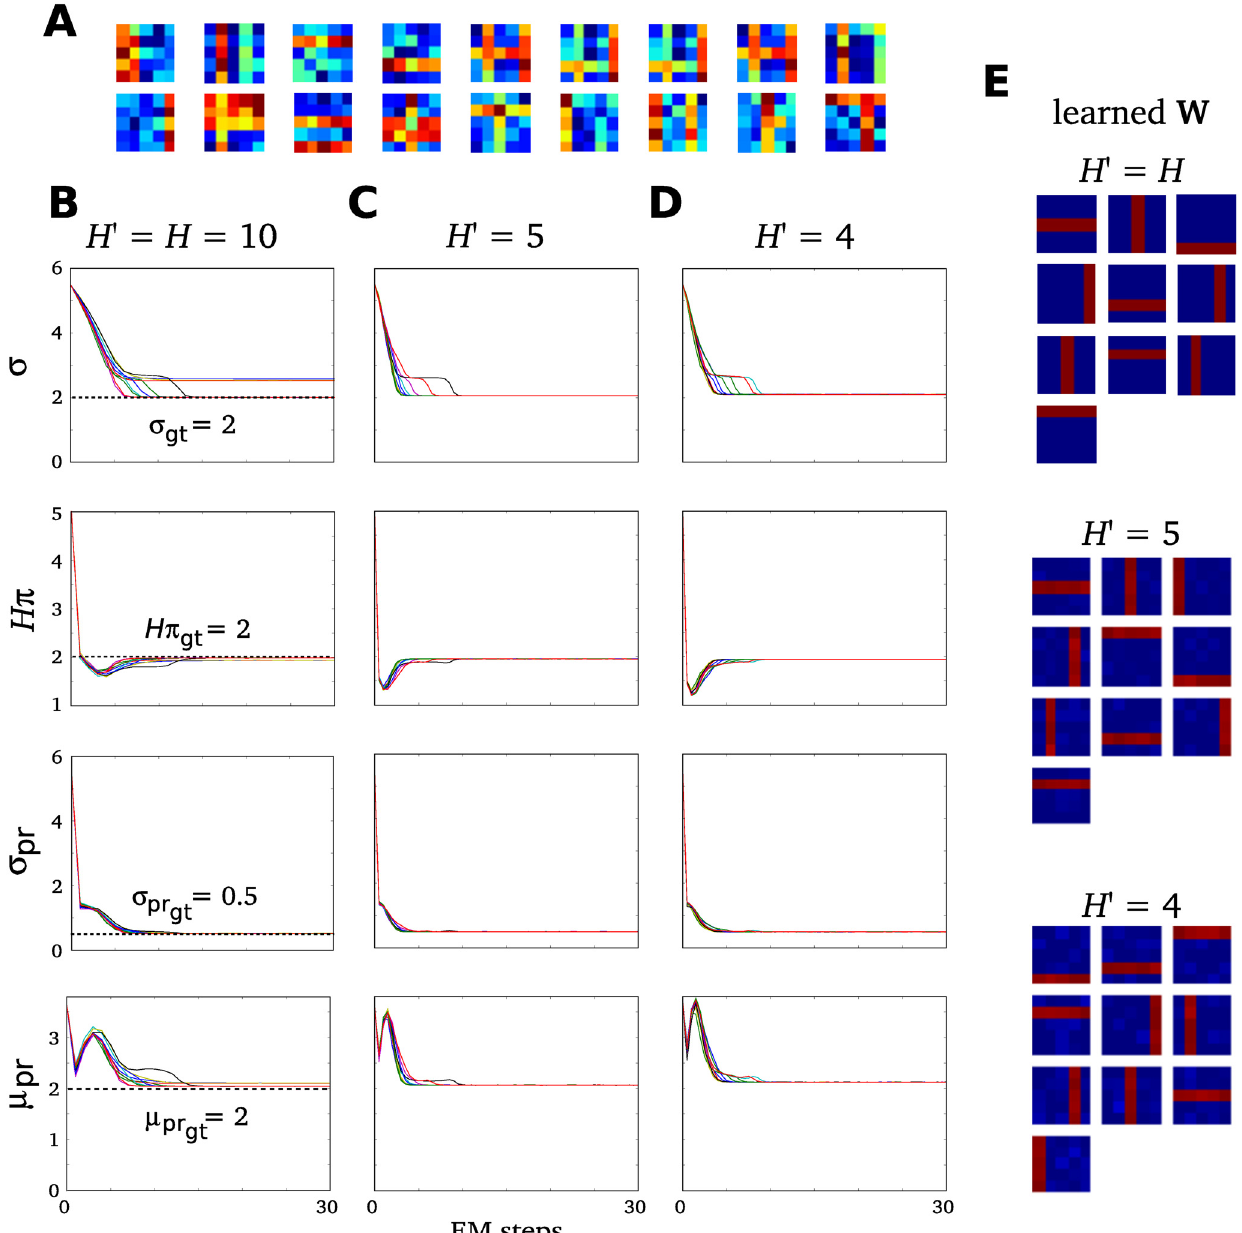
Fig 4. Parameter recovery on synthetic data. Results of three differently parameterized sets of experiments, each with 10 experimental runs of 30 EM iterations on identical artificial ground-truth data generated according to the SSMCA model: A N = 2,000, D = 5 × 5. Three shown experimental settings are: B H 0 = H = 10, C H 0 = 5, and D H 0 = 4, although the same results were obtained by the entire range of parameters H 0 = [4, 10]. Importantly, the figure shows accurate recovery of ground-truth parameters which are plotted with dotted lines. B , C and D show in each column the parameter convergence of each of the three experiments, where the rows contain the following: data noise σ , sparsity H × π , prior standard dev. σ pr , and the prior mean μ pr . Finally, E shows the set of learned generative fields/components W h corresponding to each experimental set B H 0 = H = 10, C H 0 = 5, and D H 0 = 4.